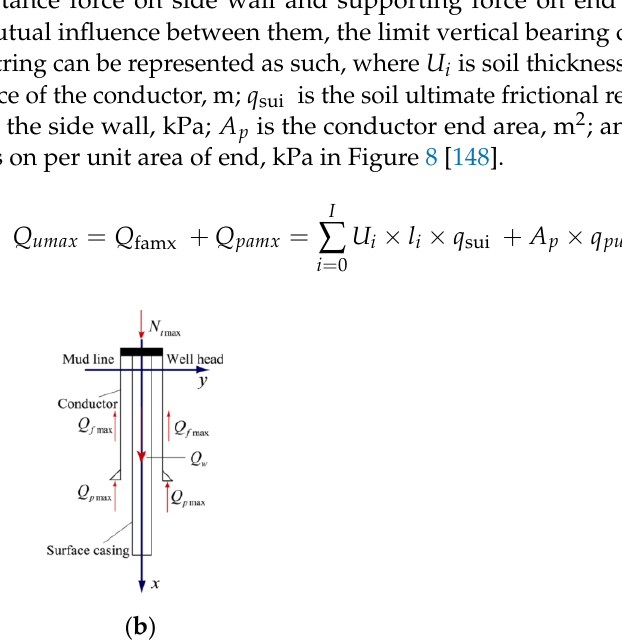
Figure 8. ( a ) Pile and soil interaction analysis model. ( b ) Vertical bearing capacity model [This figure was modified with permission from ref [148]. Copyright 2014, Elsevier].